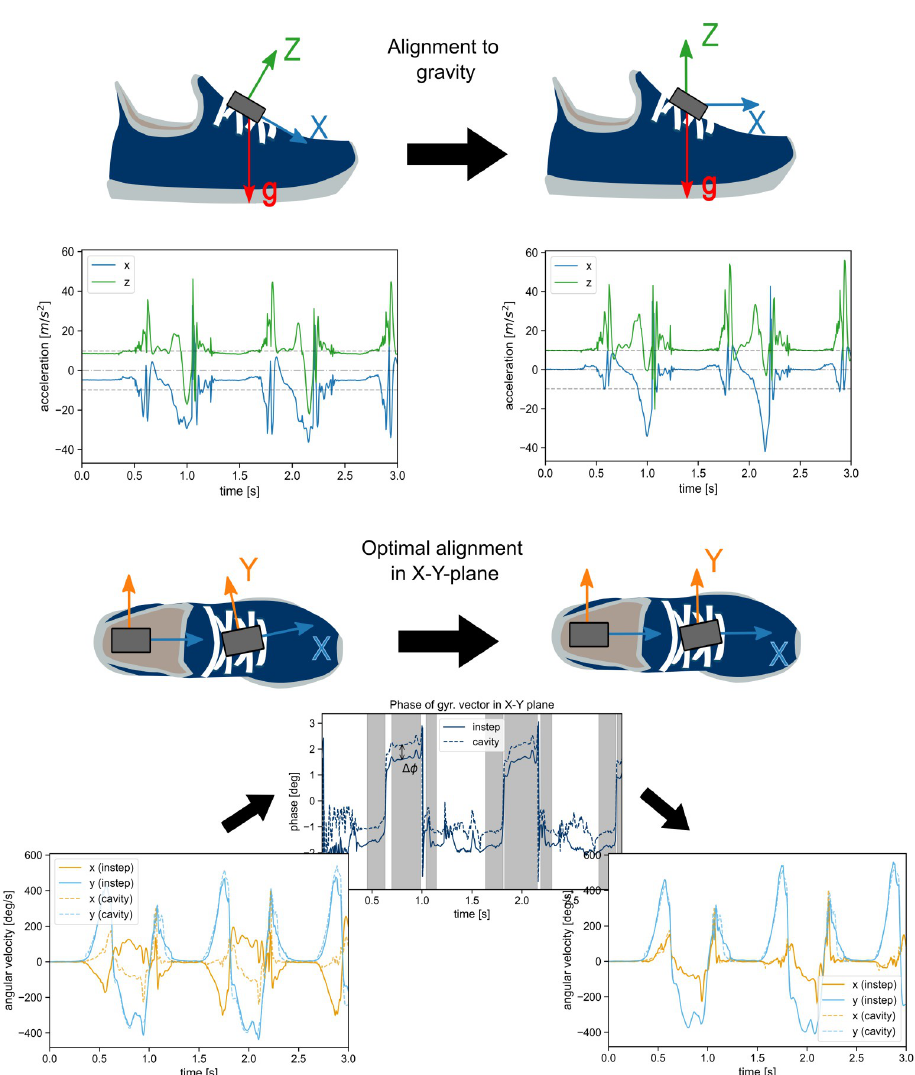
Fig 3. Visual representation of the two-step alignment procedure. The image shows the alignment of the instep sensor, but the same procedure is applied to all sensors. First, the local coordinate system is rotated, so that the z-axis aligns with the global direction of gravity during the foot-flat posture. In the second step, the rotation around the new z-axis is aligned with the cavity sensor by calculating the difference in phase between the angular velocity vectors ω xy in the x-y-plane. From the regions where the angular velocity is larger than 150 deg/s (gray areas in the plot) the median angle between the two sensors Δ φ is extracted to fully align the signals of the sensors.